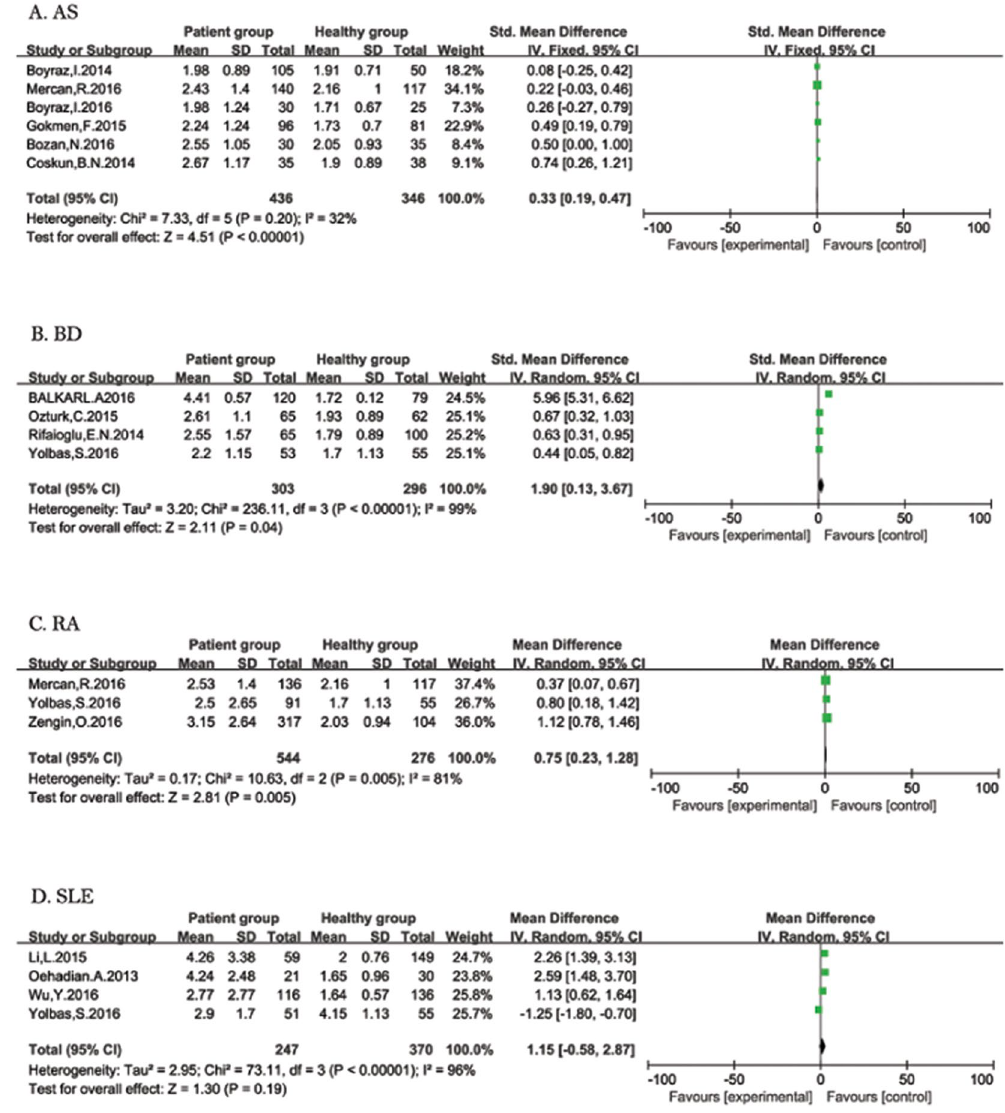
Figure 2. Forest plot of relationship between NLR and ARDs. AS ( A ), BD ( B ), RA ( C ), and SLE ( D